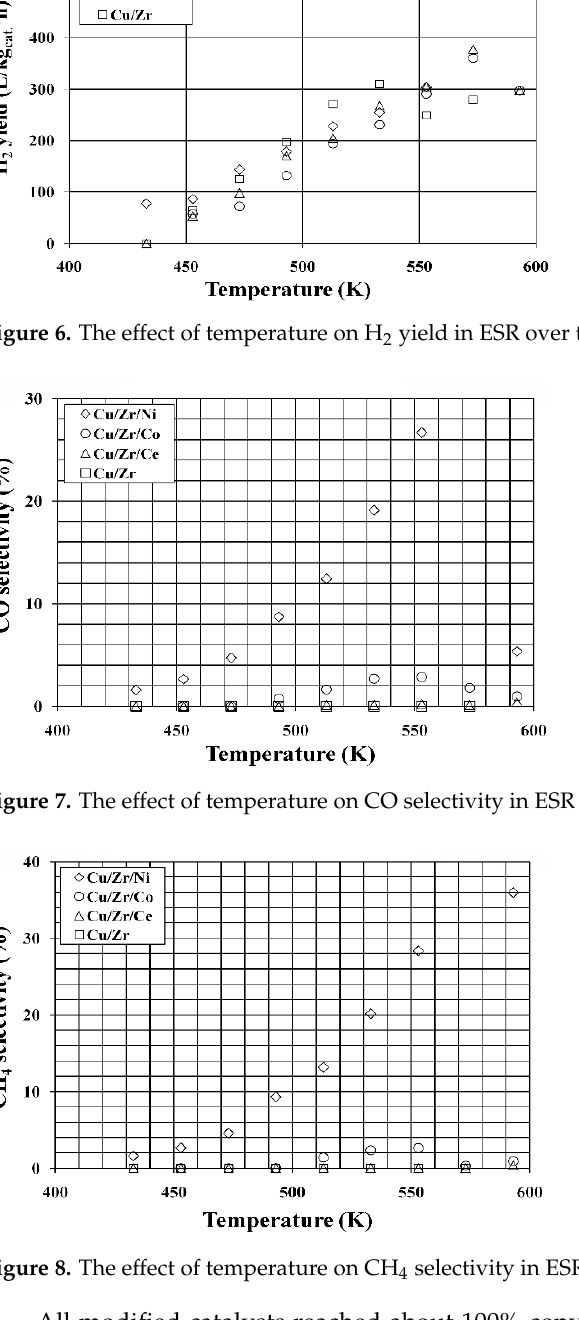
Figure 8. The effect of temperature on CH 4 selectivity in ESR over tested catalysts.